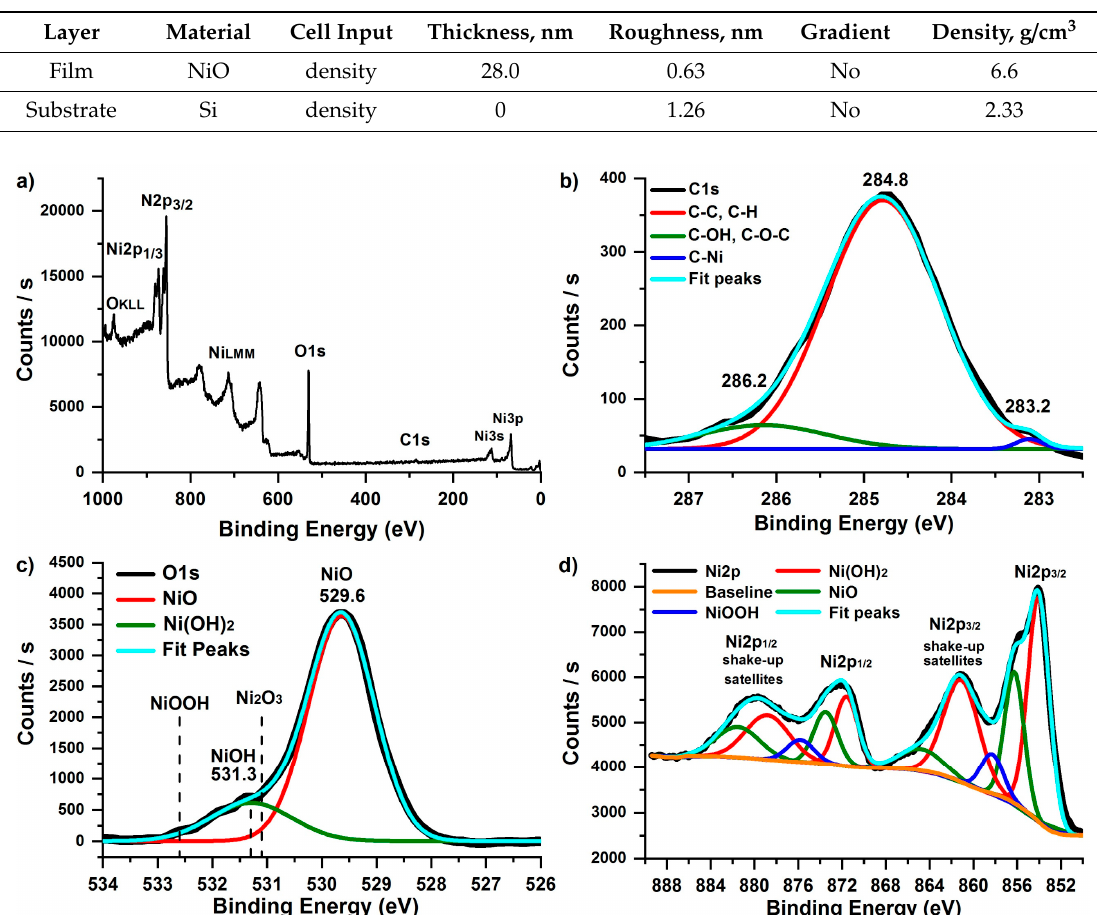
Figure 3. GIXRD ( a ) and XRR ( b ) patterns for NiO thin film deposited on silicon substrates using NiCp 2 and O 2 plasma at 300 °C during 2300 ALD cycles. Table 2. Results of XRR data treatment for sample deposited using NiCp 2 at 300 ◦ C and 2300 ALD cycles.